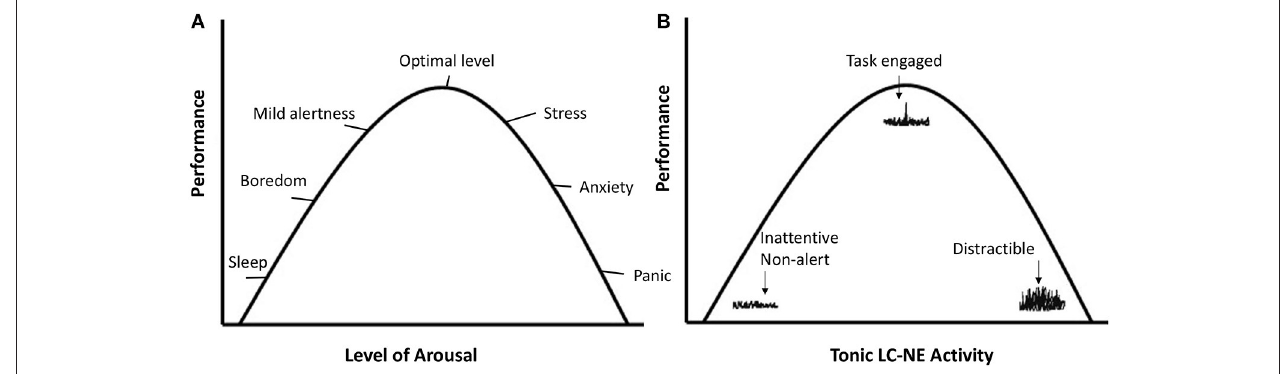
FIGURE 1 | (A) Reflects the mood states and performance as a function of the level of arousal. (B) Plots performance as a function of tonic and phasic LC-NE activity in line with the theory of Aston-Jones and Cohen (2005). On the left side, tonic LC-NE is low and so are phasic responses to stimuli. This has been referred to as the disengagement mode (Hopstaken et al., 2015). With intermediate tonic LC-NE activity, phasic LC-NE responses are strong to task-relevant stimuli. This is the exploitation mode, associated with optimal engagement and performance. On the right side, tonic LC-NE is high, and phasic LC-NE responses are undifferentiated. This is the exploration